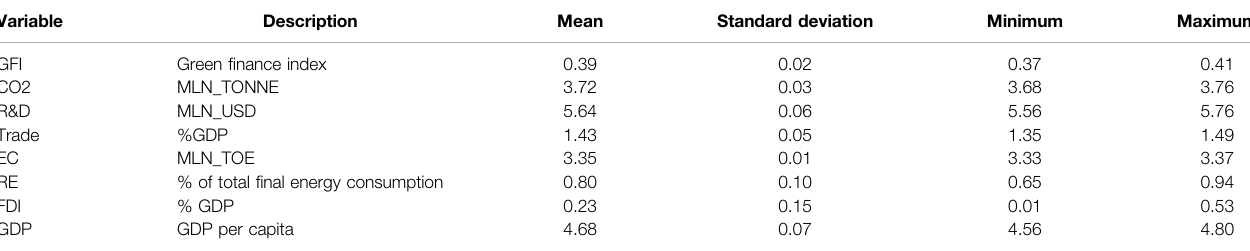
TABLE 2 | Summary